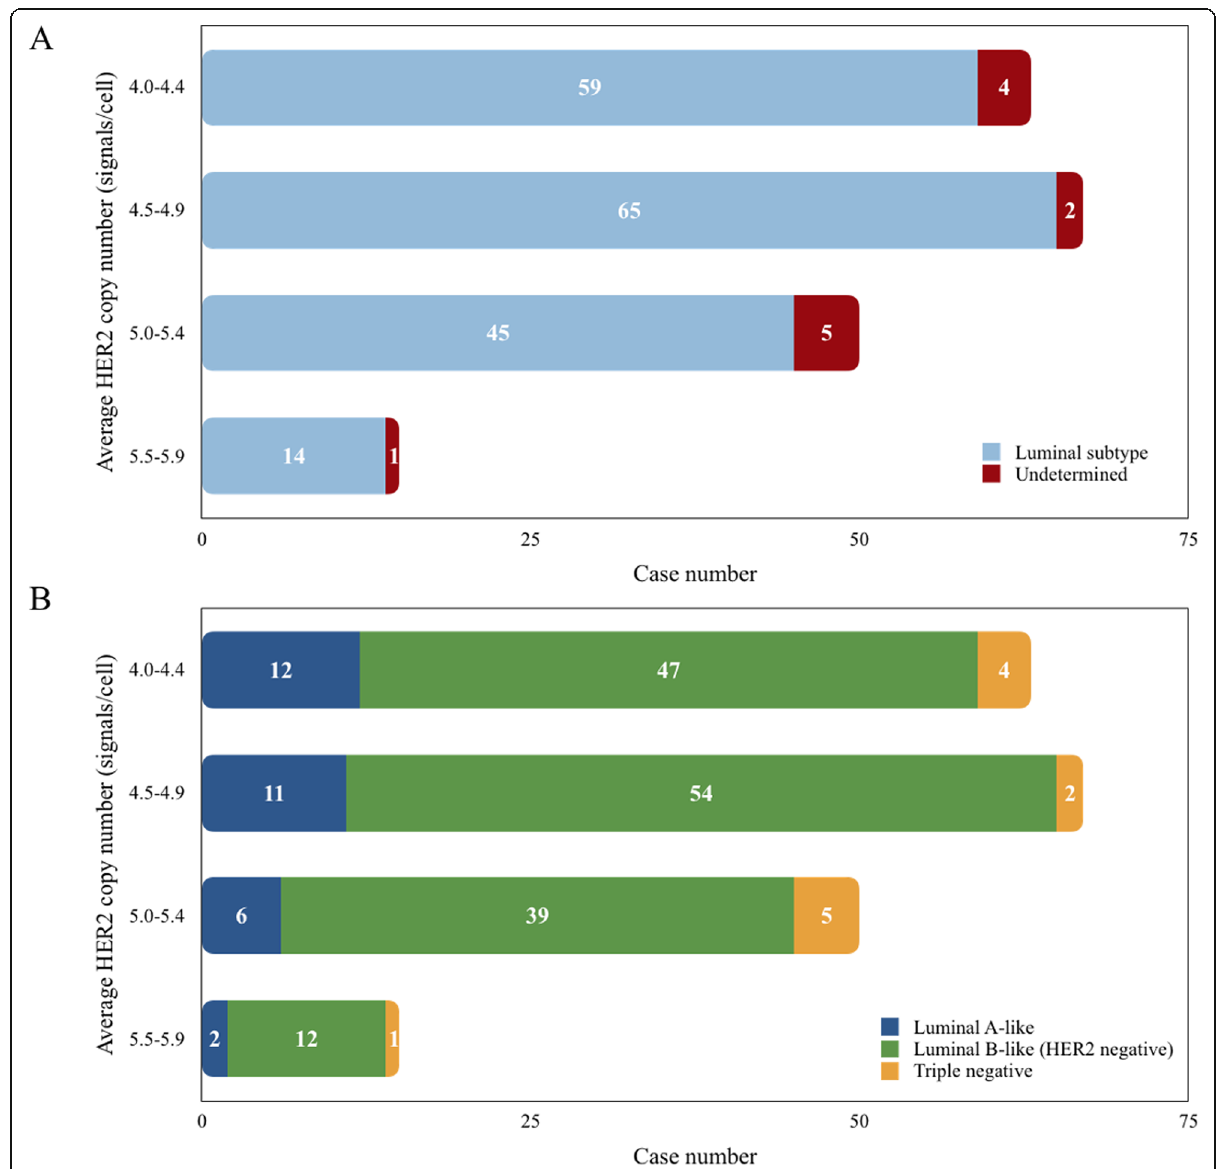
Fig. 1 Molecular subtype distribution of HER2 FISH-equivocal breast cancers in terms of average HER2 copy number according to 2013 (A) and 2018 (B) ASCO/CAP